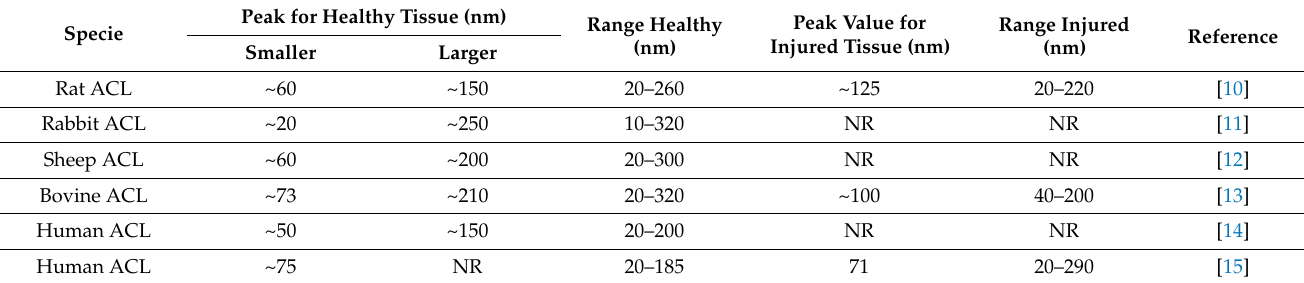
Table 1. Diameter distribution of collagen fibrils in previous